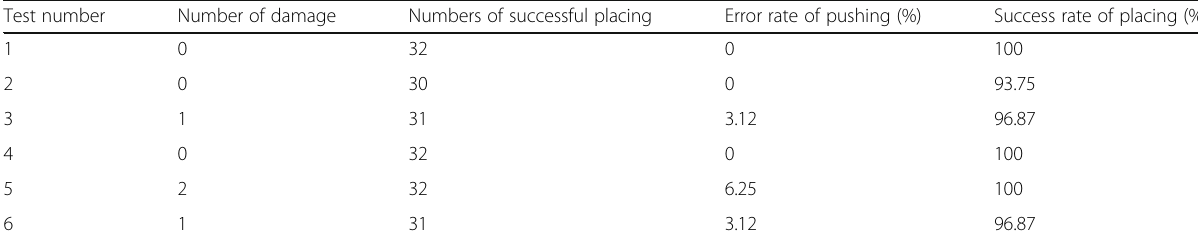
Table 2 Results of vegetable seedling placing Test number Number of